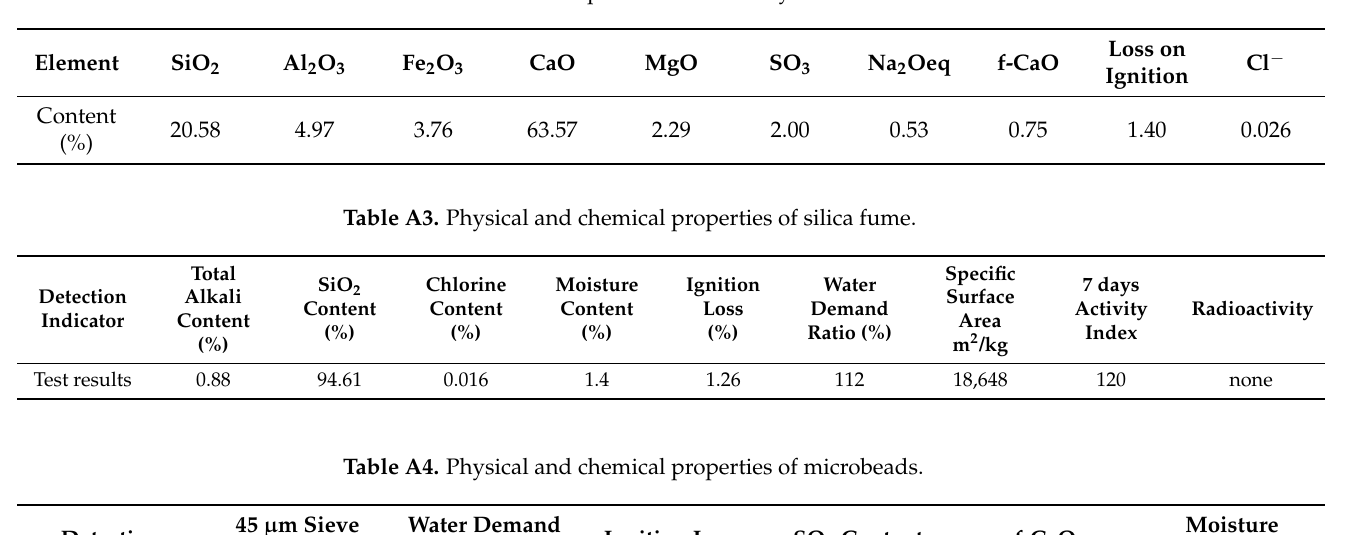
Table A2. Chemical composition of Ordinary Portland Cement.